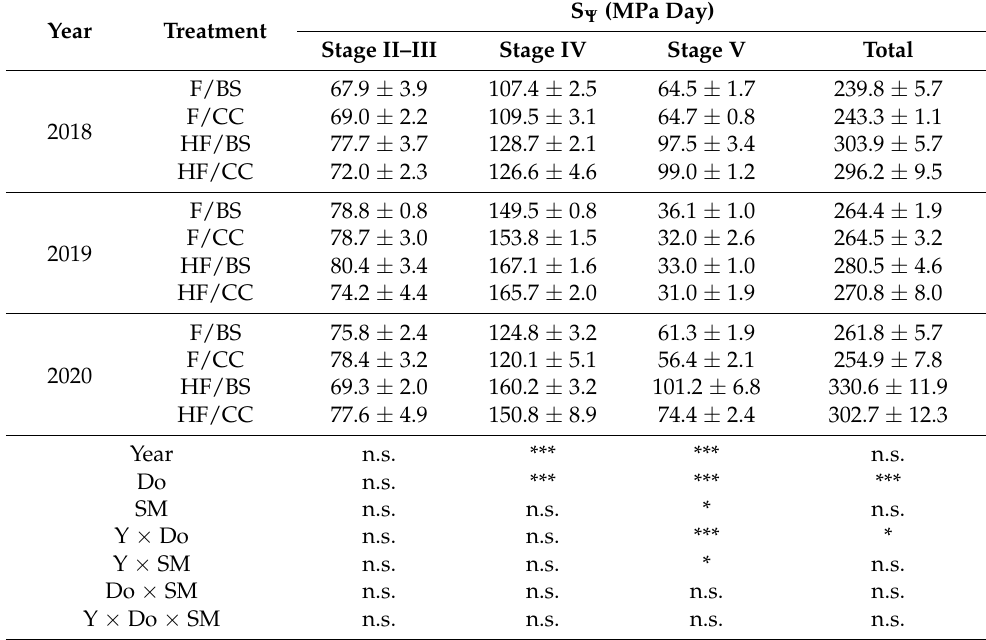
Table 2. Effects of the fertigation dose (Do) (farmer (F) and half farmer (HF)), soil management (SM) (bare soil (BS) and cover crops (CC)), year (Y) and its interactions on the water stress integral (S Ψ ) at different phenological stages and growing season. Data shows the mean ± standard